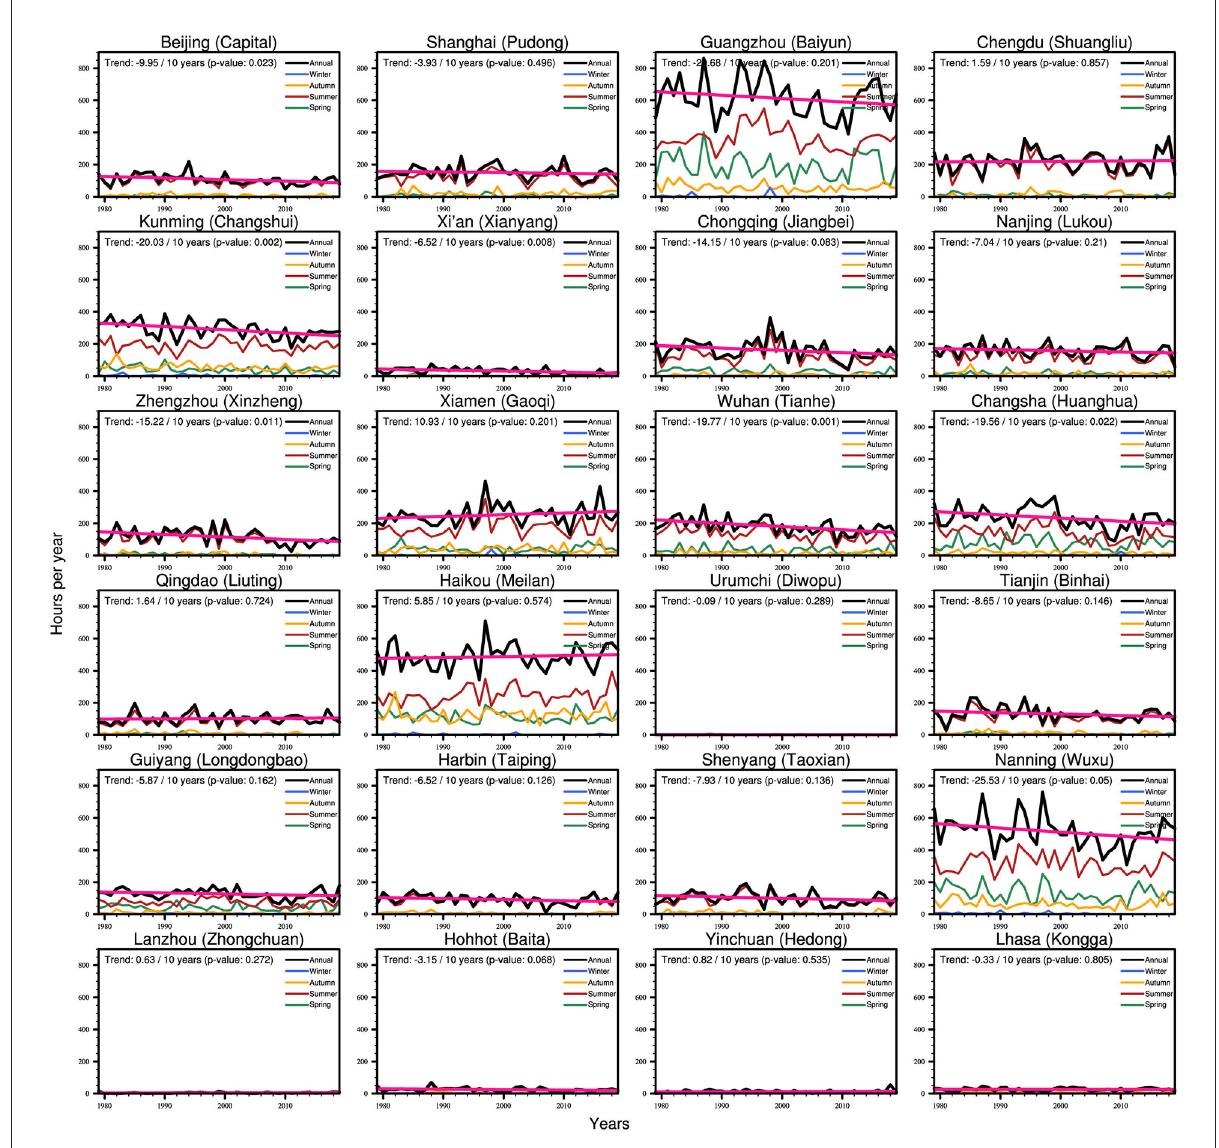
FIGURE11 Same as Figure 9, but for